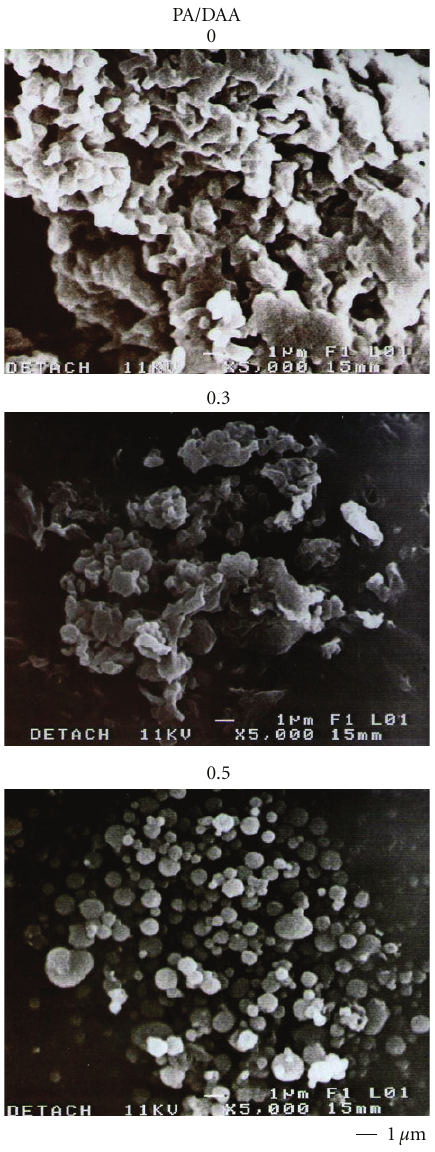
Figure 11: SEM images of the copolymer in the absence and presence of PA. POA/DAA = 7/3, heterogeneous state.